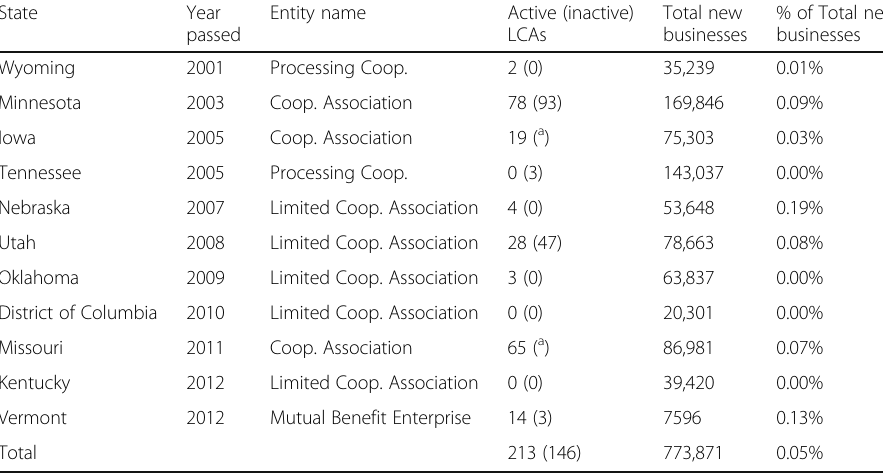
Table 2 Nominal and relative adoption of new cooperative law statutes State Year